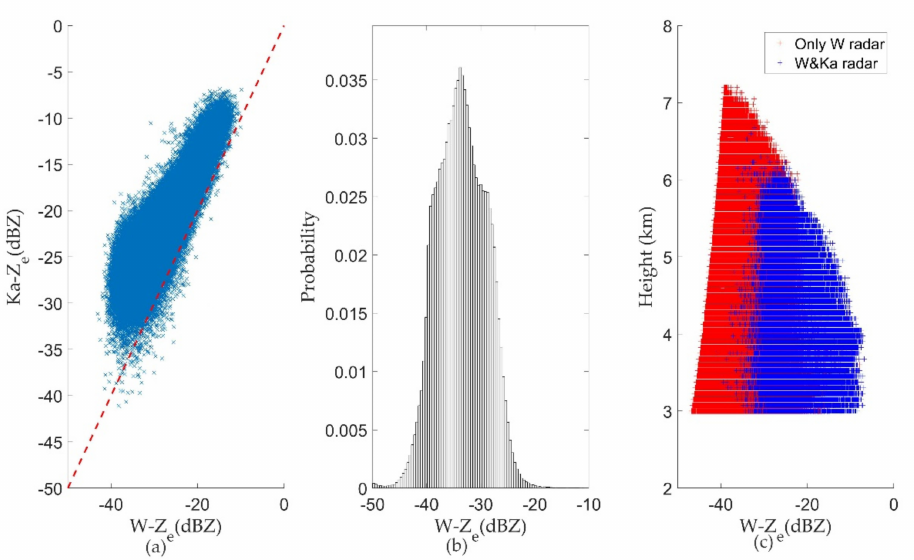
Figure 14. ( a ) The reflectivity measured by the Ka-band radar vs. the W-band radar on 19 February 2020. ( b ) The distribution of the W-band radar Z e when the Ka-band radar failed to detect the cloud. ( c ) The Z e from the W-band radar and the height for clouds that only the W-band radar detected (red) and both radars detected